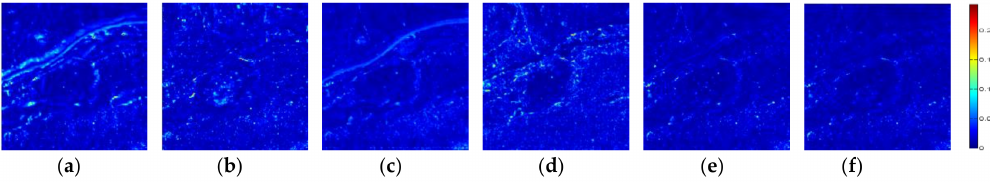
Figure 6. SAM maps of the enhanced images for Montana dataset: ( a ) MAP; ( b ) CNMF; ( c ) Bayesian; ( d ) NSSR; ( e ) LASUF; ( f ) LASUF-OM.